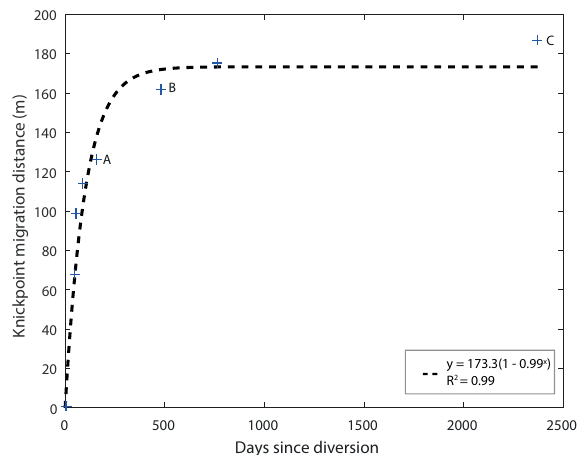
Figure 9. Plot between days since diversion and distance of head- ward knickpoint migration (m). Letters A–C correspond to the se- quence of images in Fig.